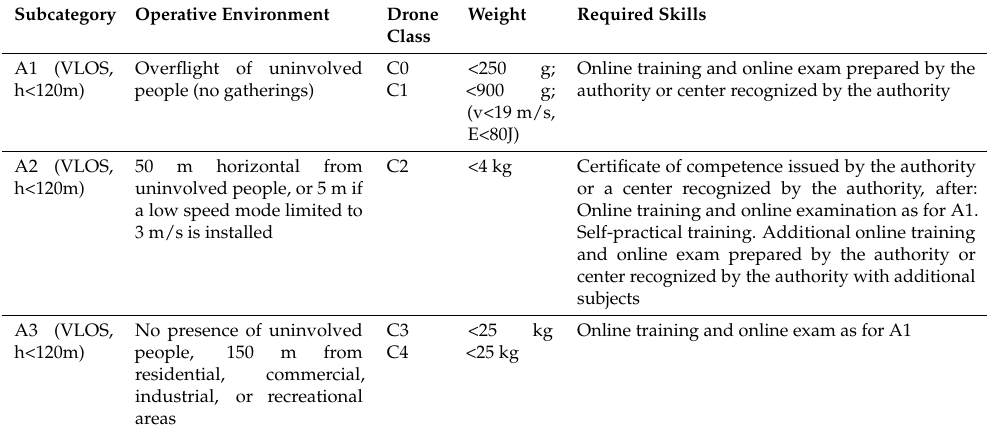
Table 1. Table of